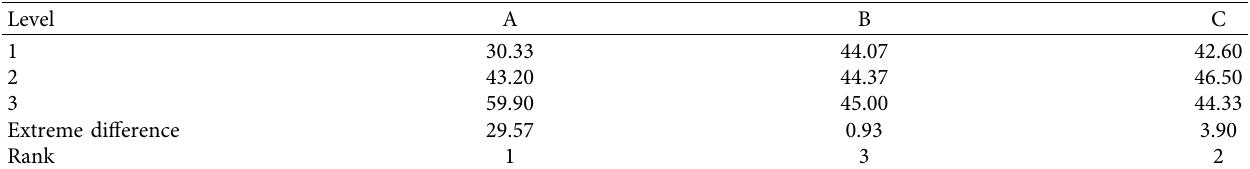
Figure 18: Reinforcement pull-out test. (a) Reinforcement pull-out test setup. (b) Schematic diagram of the reinforcement pull-out test setup. Table 11: Mean principal